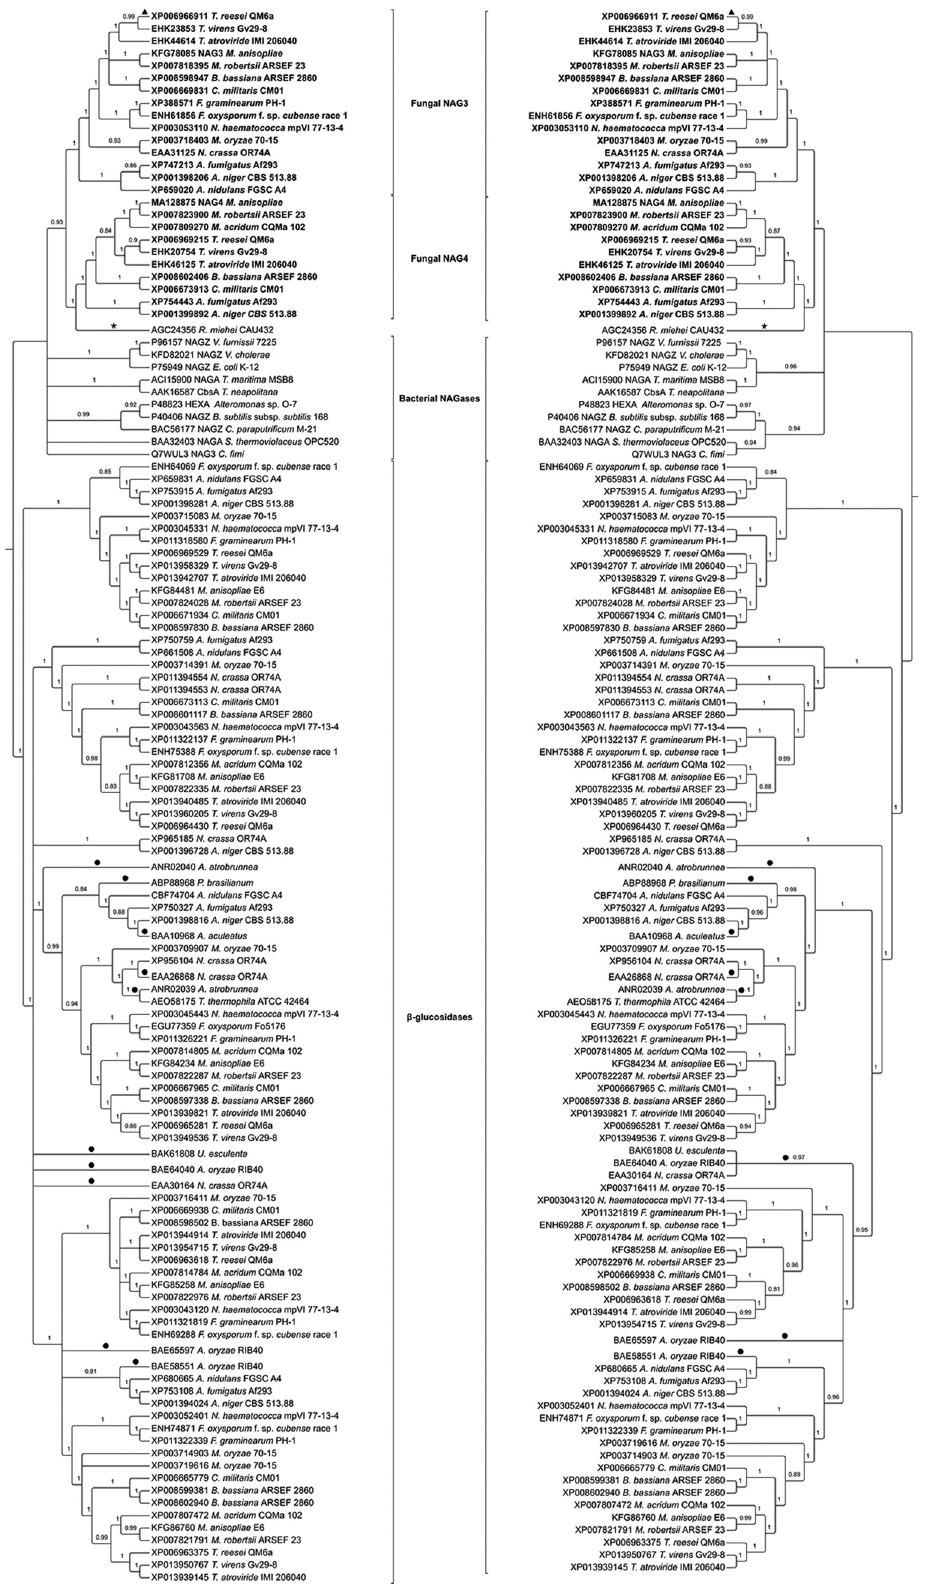
Figure 2 - Phylogenetic relationships among GH3 NAGases from filamentous fungi, bacteria and zygomycetes. Putative and characterized fungal GH3 (cid:2) -glucosidases were included as an outgroup. The phylogenies were obtained using MrBayes 3.2.5 (left side) and PhyML 3.1 (right side). (cid:2) : NAGase from the zygomycete Rhizomucor miehei . (cid:3) : Nodes with support values below 0.8 were collapsed into